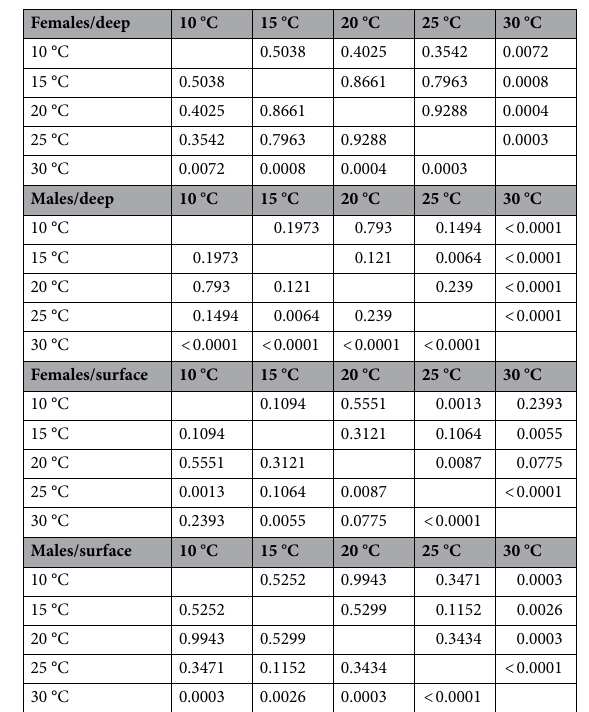
Table 4. p -values of the lowest haemoglobin concentration values after cooling at different